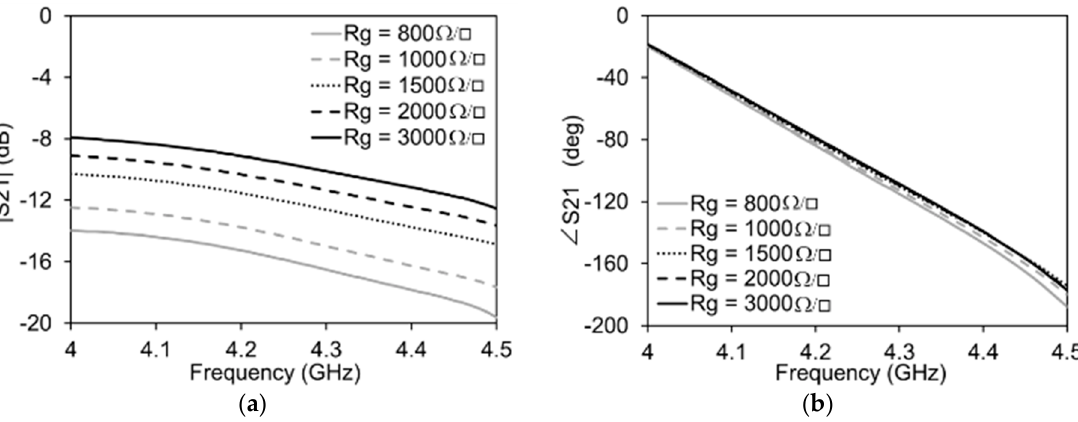
Figure 4. Simulations of the attenuation mode of the transmission line with Rg1 = 3000 Ω / (cid:3) for all cases: ( a ) Amplitude variation; ( b ) Phase variation.